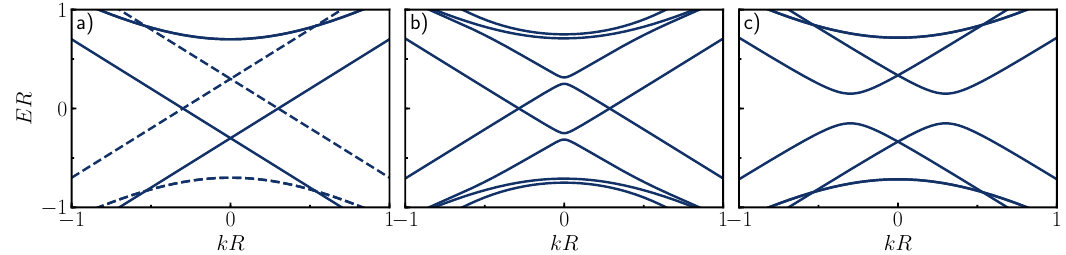
Figure 2: Spectra of topological insulator nanowires obtained from the effective Hamiltonians in Eq. (5) with µ R = 0.3, when a flux of η = 1 / 2 is applied. a) In the R = 0, the spectrum is gapless with an odd number of modes absence of pairing, ∆ 0 at any E . Electron and hole modes are shown with full and dashed lines,